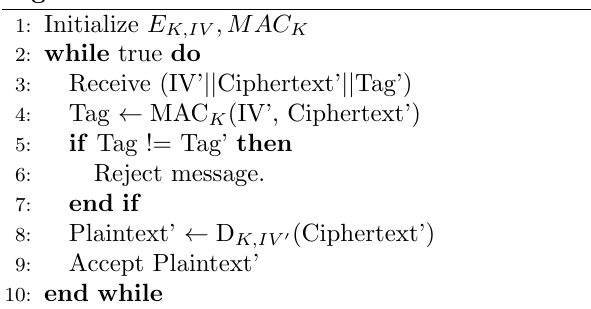
Figure 4: An overview of how a vehicle may be enhanced with secure signal transmission. The cryptographic algorithms are applied immediately before transmission and upon reception. Whether encryption, au- thentication, or authenticated encryption is applied would depend on which cryptographic properties are of interest. Algorithm 2 D block